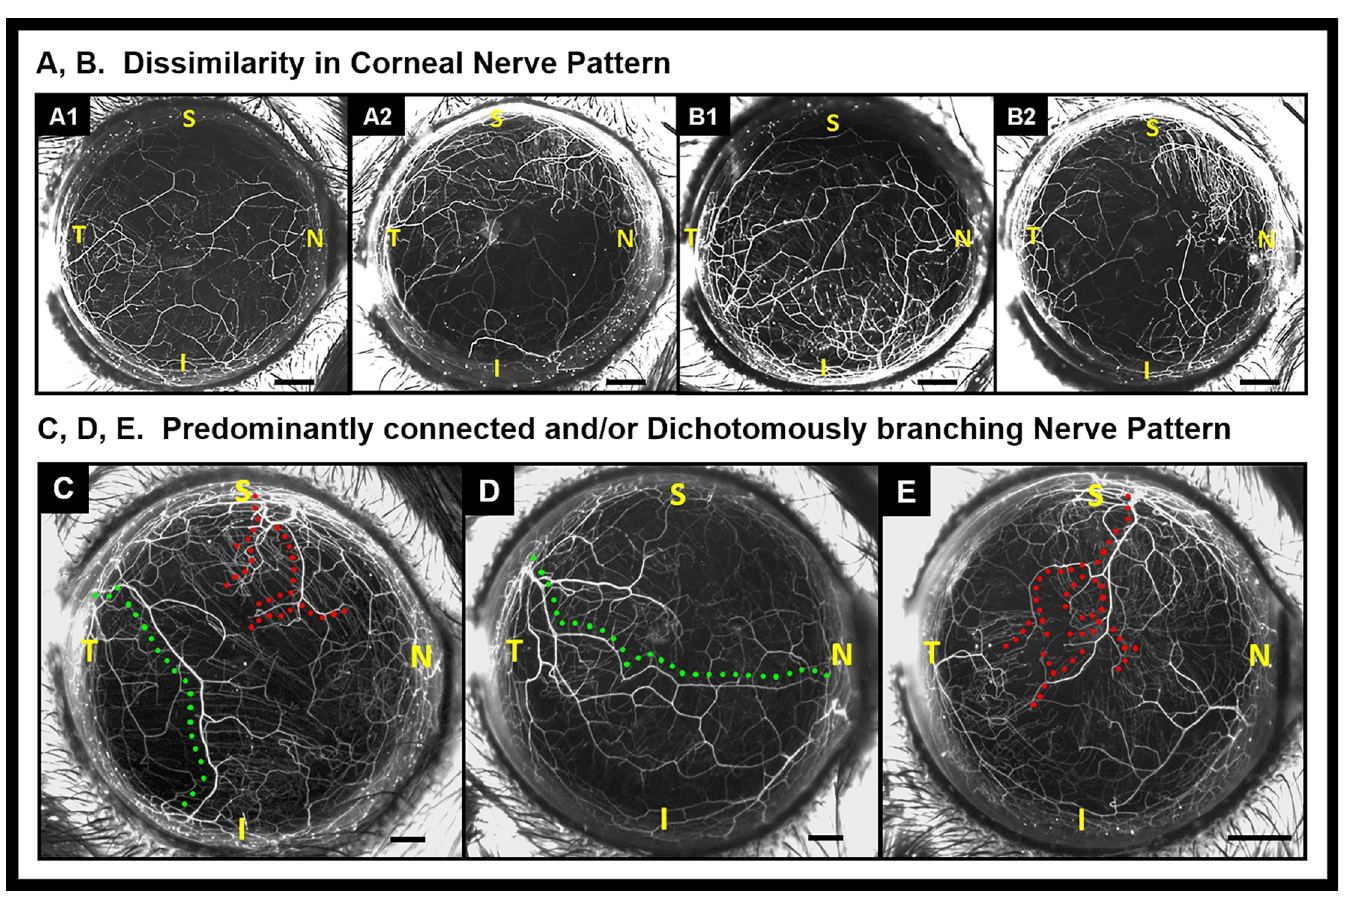
Fig 1. Dissimilarity in corneal nerve patterns. Stereoflourescent microscope image of cornea shows nerve patterns are dissimilar within the same mouse (OS and OD; A1 and A2 respectively) and between littermates (OS of two littermates; B1 and B2 respectively). (C—E) Stereoflourescent microscope images of corneal nerves showing different branching patterns. (C) Dichotomously branching trunks terminate near the corneal apex (red dotted line) and interconnected nerve trunks (green dotted line) span limbus to limbus. (D) Interconnected pattern (green dotted line). (E) Dichotomously branching pattern (red dotted line). S: Superior; I: Inferior; N: Nasal; T: Temporal position; Black scale bars in Panels A—E: 500 μ